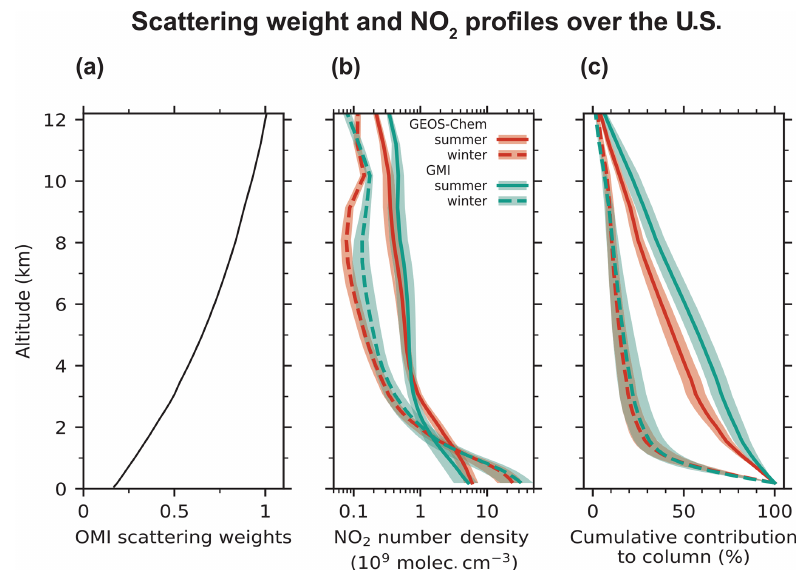
Figure 9. Seasonal mean vertical profiles of sensitivity (scattering weights) of the OMI satellite instrument, NO 2 number density, and cumulative percent contributions to tropospheric NO 2 columns as would be observed by OMI over the contiguous U.S. Panel (a) shows the mean profile of the scattering weights from the NASA OMI NO 2 (v4.0) retrievals averaged over summer and winter for scenes with cloud fraction < 0.1 and surface albedo < 0.3. There is little difference in the scattering weight profile between winter and summer. Panel (b) shows the afternoon NO 2 profiles simulated by GEOS-Chem and GMI for summer (June, July, and August) and winter (December, January, and February) for the year 2015. The x axis is shown on a log scale. Panel (c) shows the cumulative percent contribution from NO 2 at different altitudes to the tropospheric NO 2 columns, as measured by OMI for summer and winter. It is calculated using Eq. (7). The shaded areas in panels (b) and (c) depict the standard